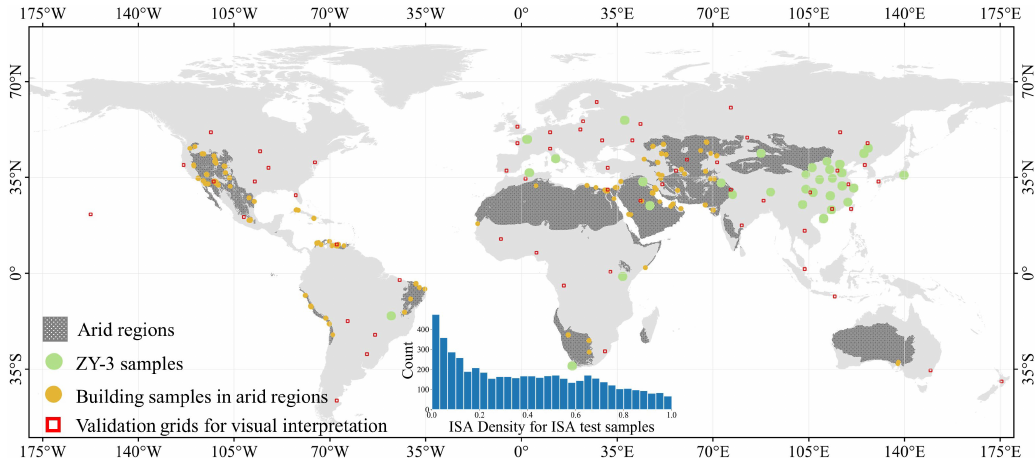
Figure 5. Global distribution of the test samples and grid used in this study, including (1) 59 grids for visual interpretation, (2) ZY-3 reference set covering 23 cities, and (3) 5385 building samples in the arid regions. The arid regions were extracted from “deserts and xeric shrublands” biome in Olson et al. (2001). The inner graph shows the ISA density within the 0.5km buffer for the ISA test samples.